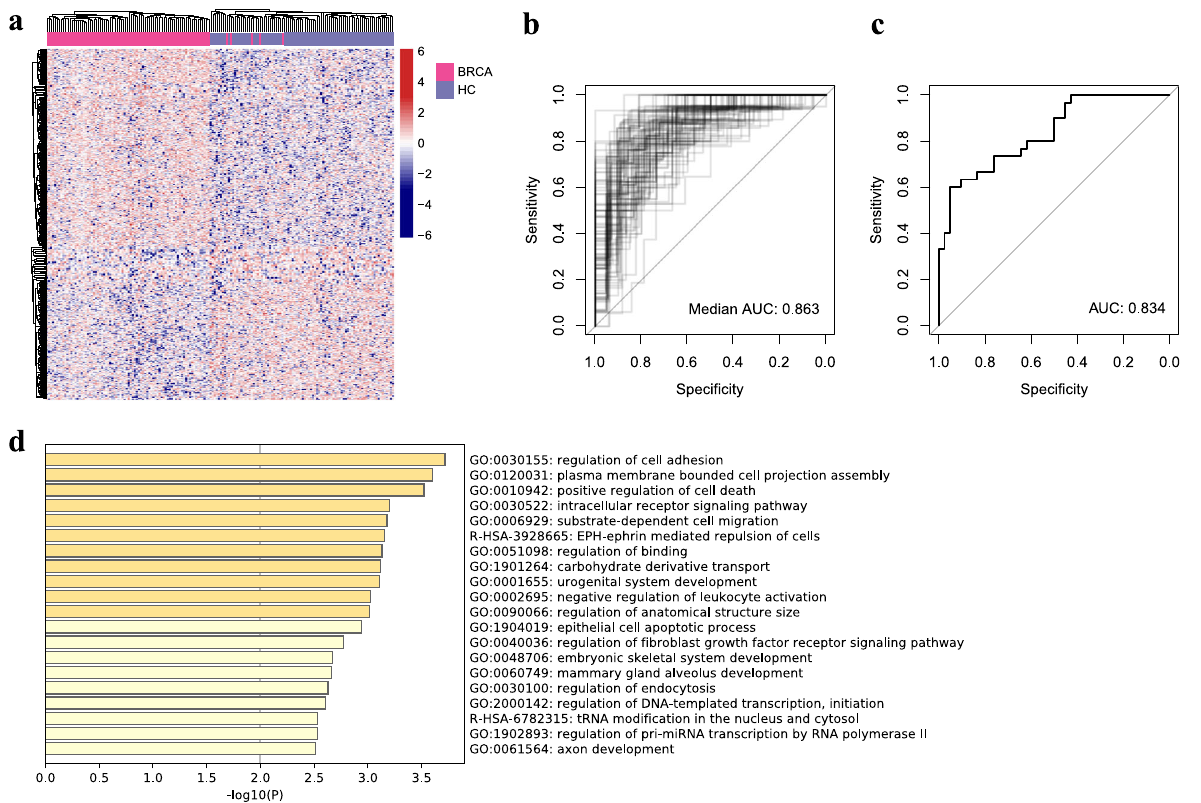
Fig. 5 Prediction of breast cancer patients. a Heatmap of different TSS region coverage between patients with breast cancer and healthy donors. Receiver operating characteristic (ROC) curves for the classi fi er in training cohort ( b ) and in validation cohort ( c ). d The top 20 signi fi cantly different pathways between breast cancer and healthy